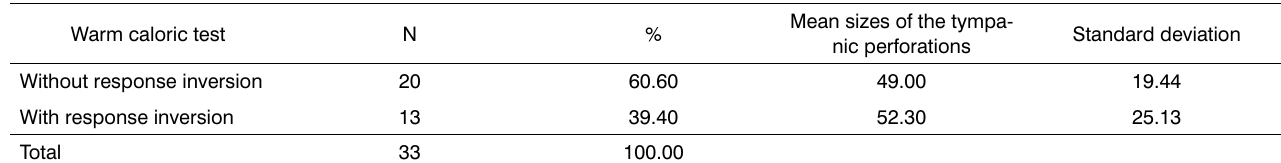
Table 5. Mean sizes of the tympanic membrane perforations associated with the presence or absence of response inversion in the warm calo- ric